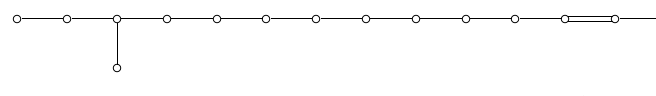
Figure 11. The Coxeter pyramid group Γ 13 ⊂ Isom H 13